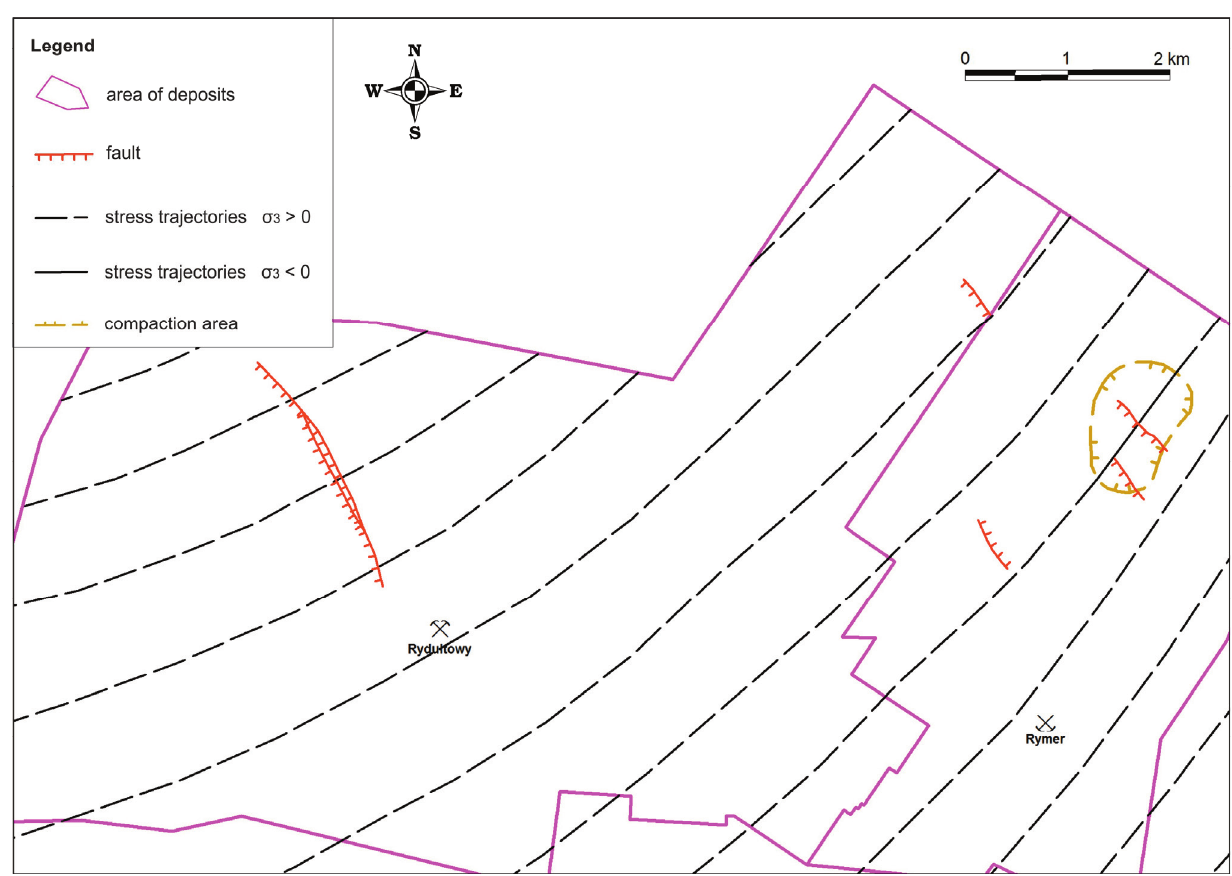
Fig. 2. Fragment of the map showing the tectonics stress field causing fracturing of system